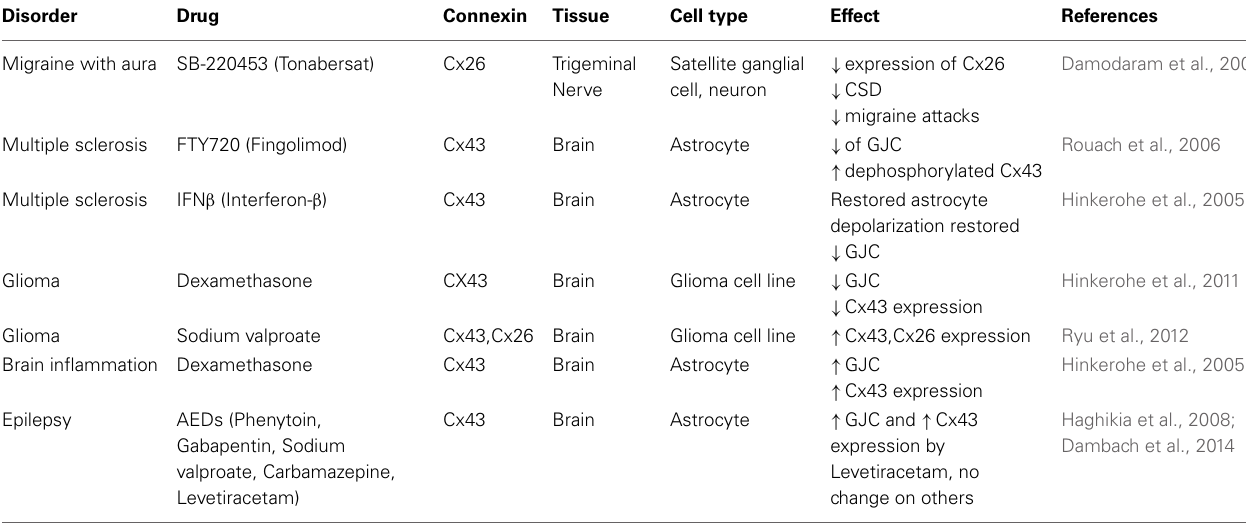
Table 1 | Summary of the available information in regard to GJs and brain pathologies in in vitro